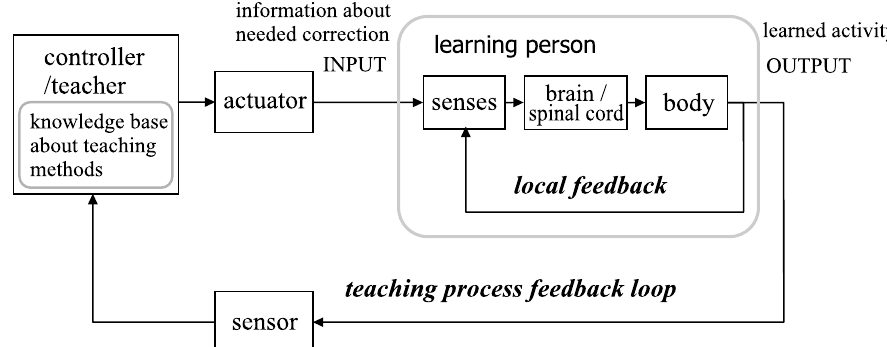
Figure 1. The scheme of the learning process with teacher participation. The motion activity of the learner’s body is evaluated by the teacher or automatic controller, which uses an actuator to send feedback to the learner. The object of this process (i.e., the learner) uses the local feedback loop to control his or her